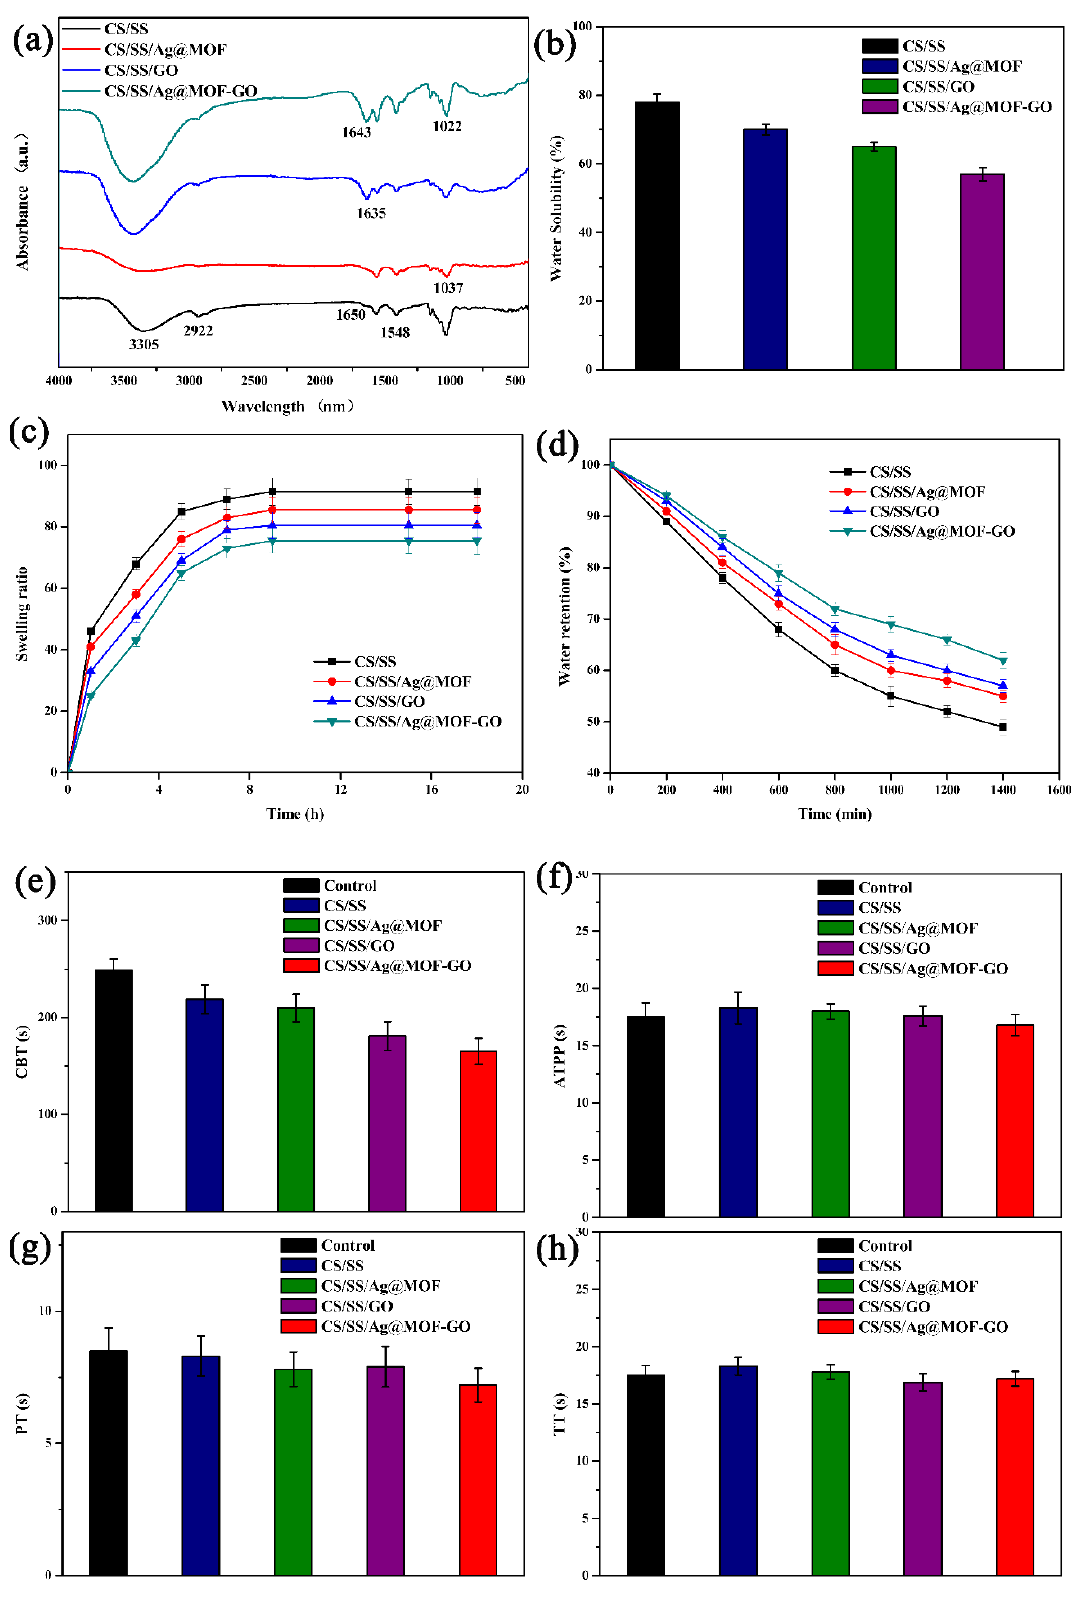
Figure 3. ( a ) FTIR spectrum, ( b ) water solubility, ( c ) swelling degree, ( d ) water retention, ( e ) CBT, ( f ) APTT, ( g ) PT, and ( h ) TT of CS/SS, CS/SS/Ag@MOF, CS/SS/GO and CS/SS/Ag@MOF–GO.